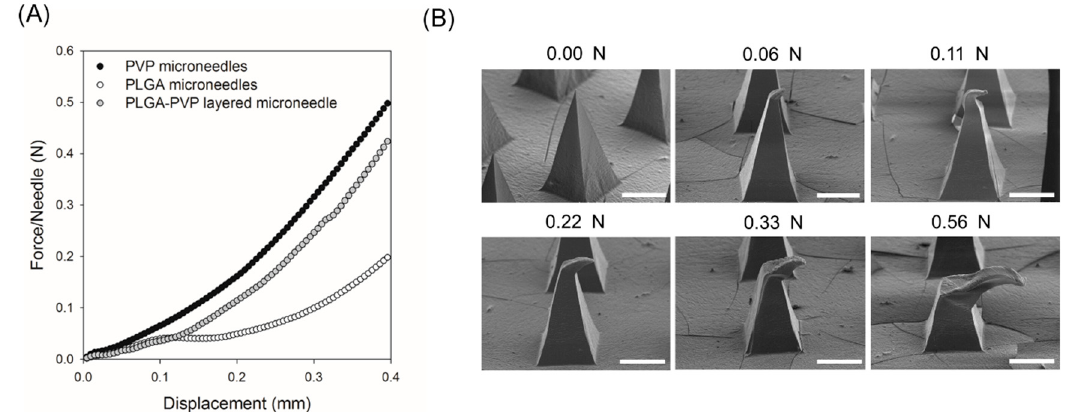
Figure 4. Mechanical behavior of PLGA–PVP layered microneedles. ( A ) Force–displacement curves generated by a compression test. ( B ) SEM images of the layered microneedles after applying different compressive forces. Scale bars represent 200